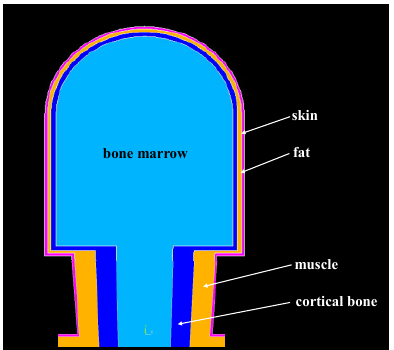
Figure 2. The modeling of head and neck.